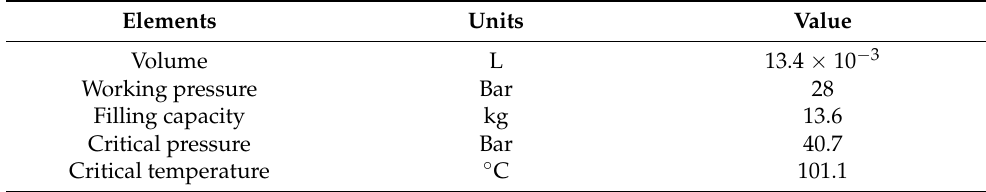
Table 7. Characteristics of the